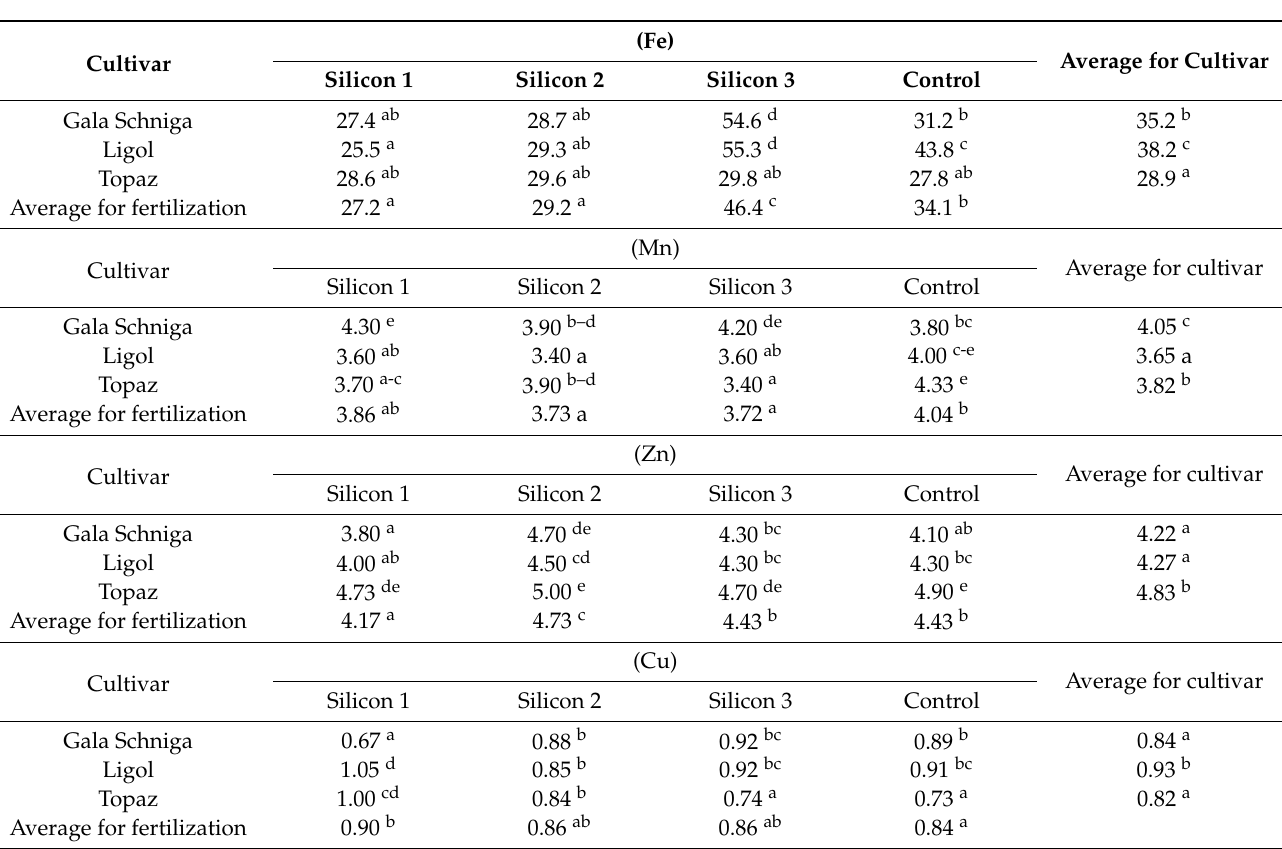
Table 16. The content of micronutrients in fruits depending on cultivar and foliar silicon treat- ment